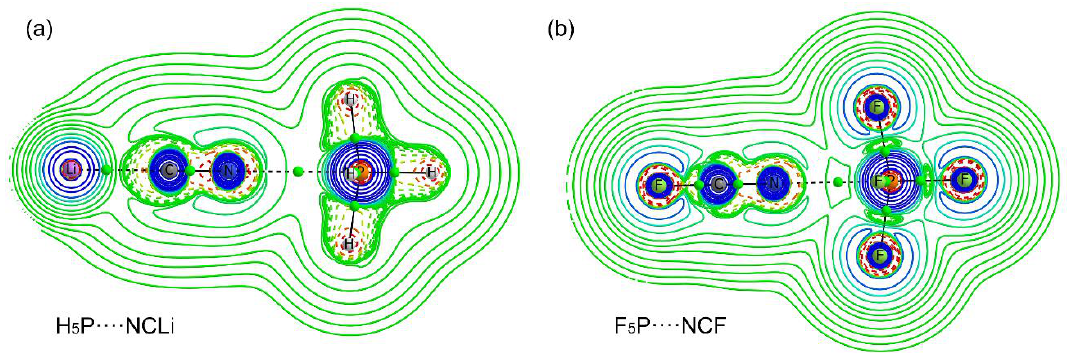
Figure 13. ( a ) Laplacian of the electron density on the molecular plane of H 5 P···NCLi complex; ( b ) F 5 P···NCF complex [150].